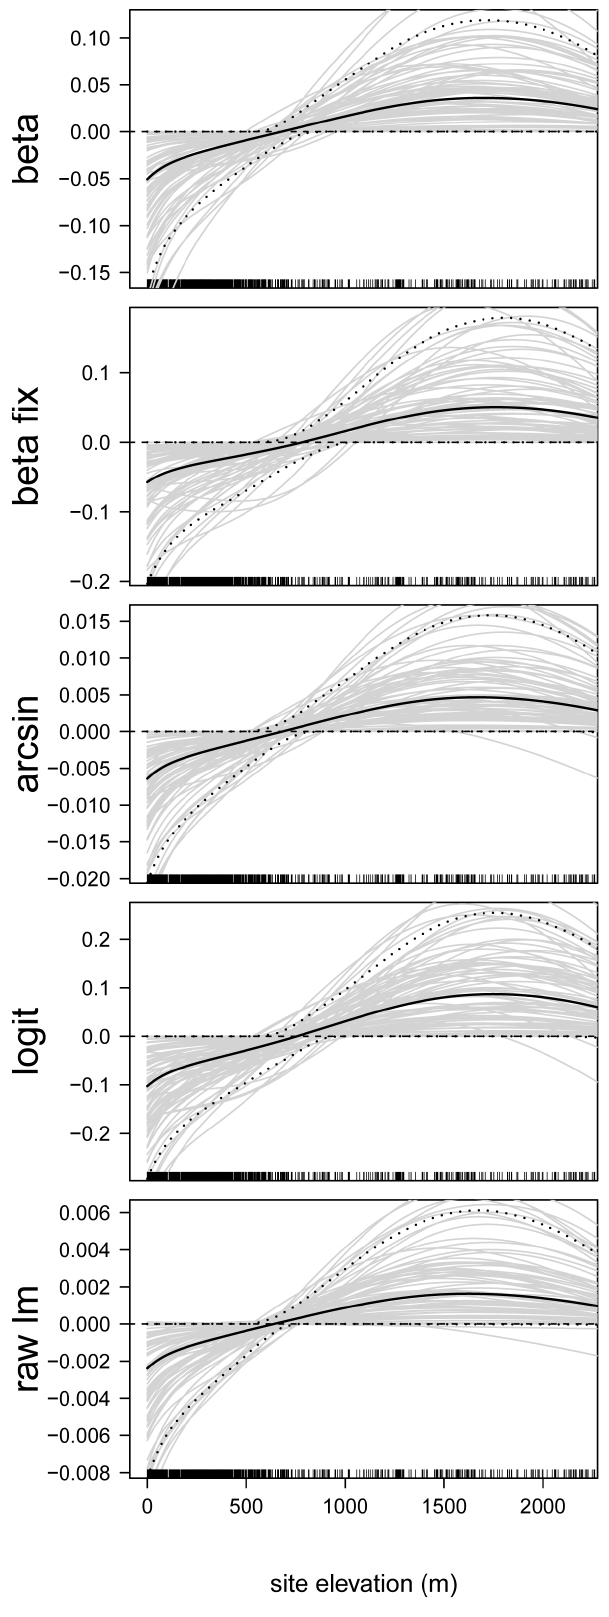
Figure 7. Function estimates for the site elevation. Analysis of the NLA Data. The five panels contain the function estimates for the site elevation (computed from 100 bootstrap samples). In case of beta regression, estimates present the effects of the site elevation on the mean parameter m . Black lines correspond to the mean and the 0.05 and 0.95 quantiles of the function estimates. For reasons of interpretability, the range of the x-axes was restricted to the lower 95% of the sample